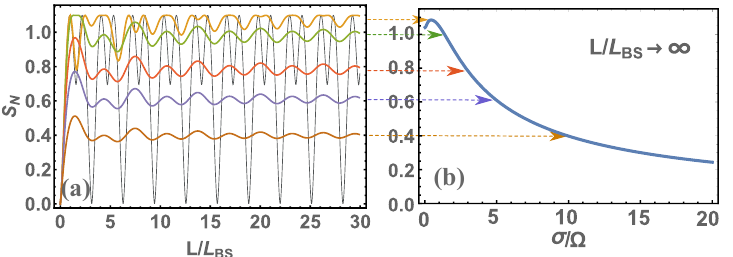
Figure 3. The calculation is presented: ( a ) quantum entanglement S N at different parameters σ / Ω = { 0,1/2,3/2,3,5,10 } (respectively, the color of the graphs in the figure: { black, yellow, green, red, blue, brown } ) depending on the dimensionless BS length L / L BS ; ( b ) the same but with larger dimensions of the BS, i.e., at L / L BS → ∞